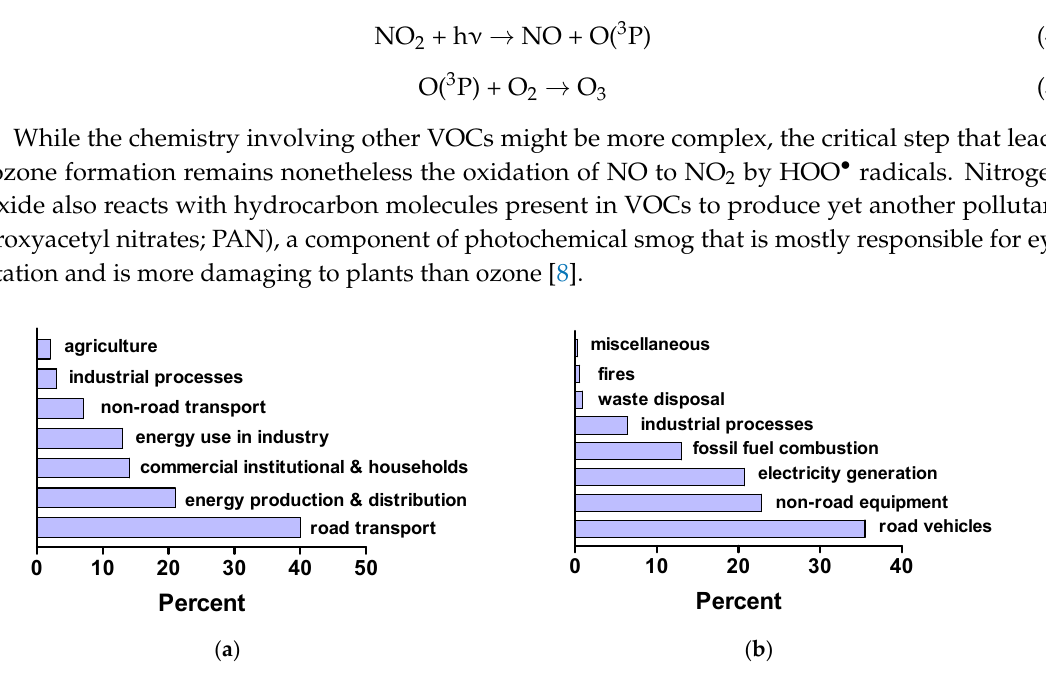
Figure 1. Graphic illustrating the natural and anthropogenic sources of atmospheric pollution together with primary and secondary atmospheric pollutants from various sources that ultimately lead to the formation of acid rain.